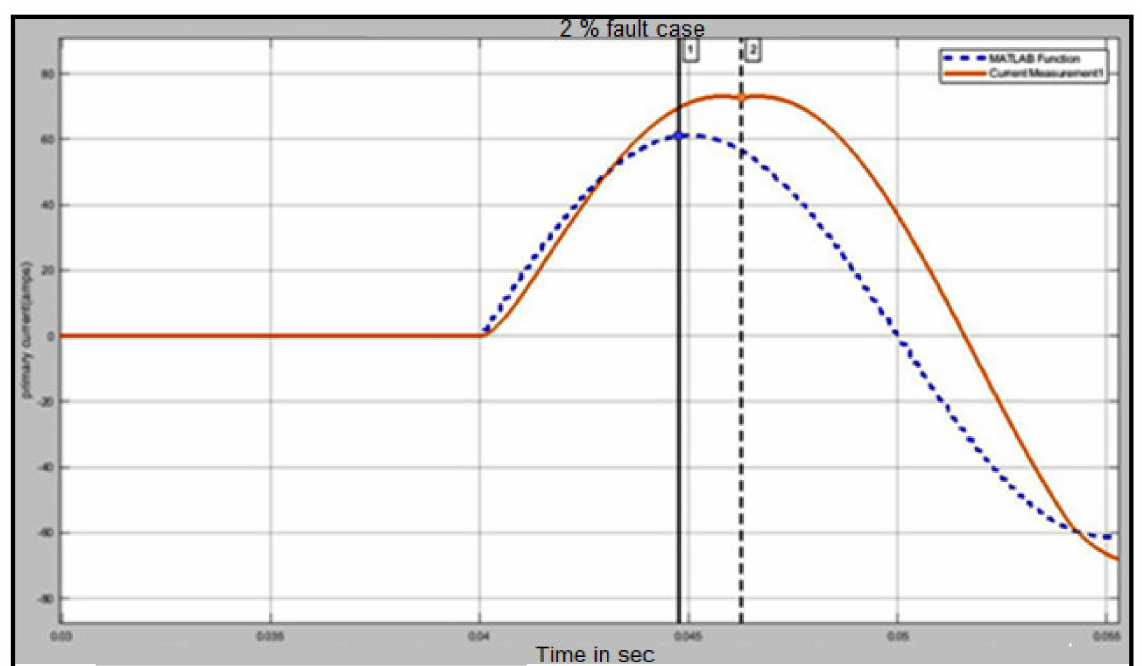
Figure 17. EKF estimation during energization with a 2% internal fault.